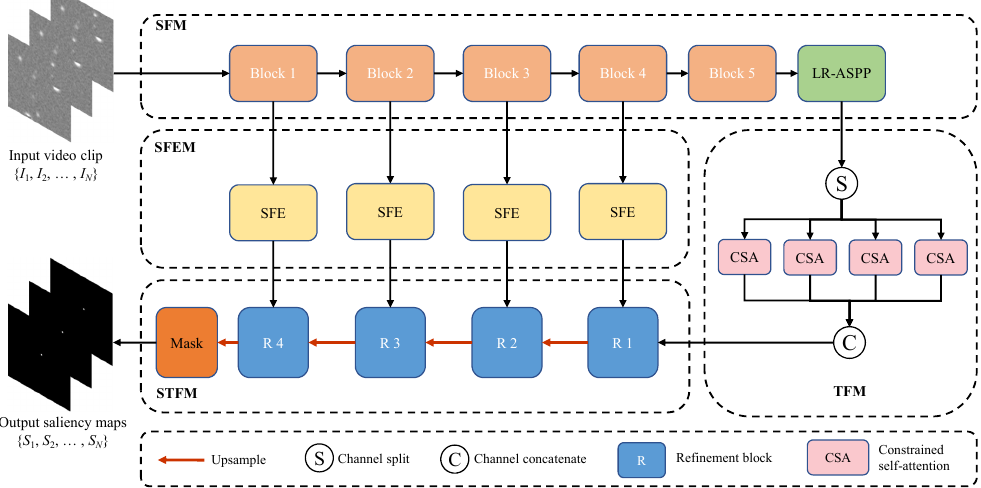
Figure 2. Detailed illustration of the proposed saliency detection network, which consists of the spatial feature extraction module, spatial feature enhancement module, temporal feature extraction module, and saliency prediction